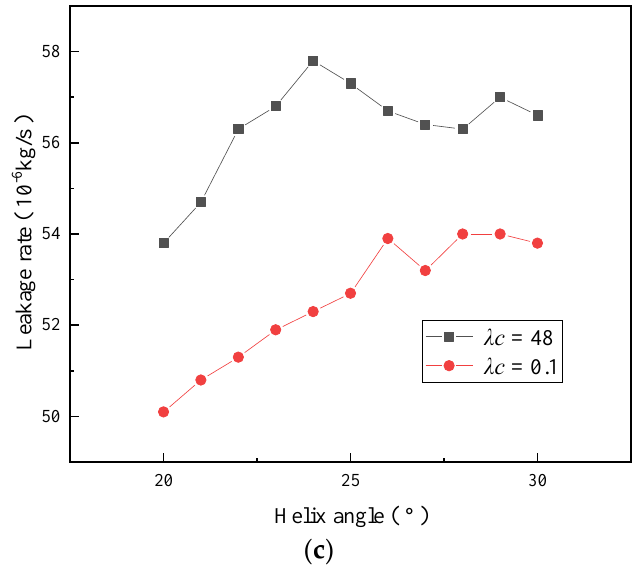
Figure 5. Effect of helix angle on sealing performance. ( a ) Effect on the average vapor phase volume fraction. ( b ) Effect on the opening force. ( c ) Effect on the leakage rate.